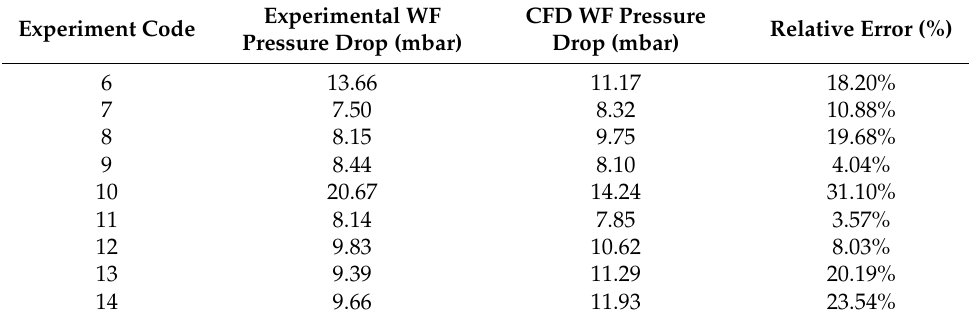
Table 6. Experimental and CFD pressure drop results with relative error.